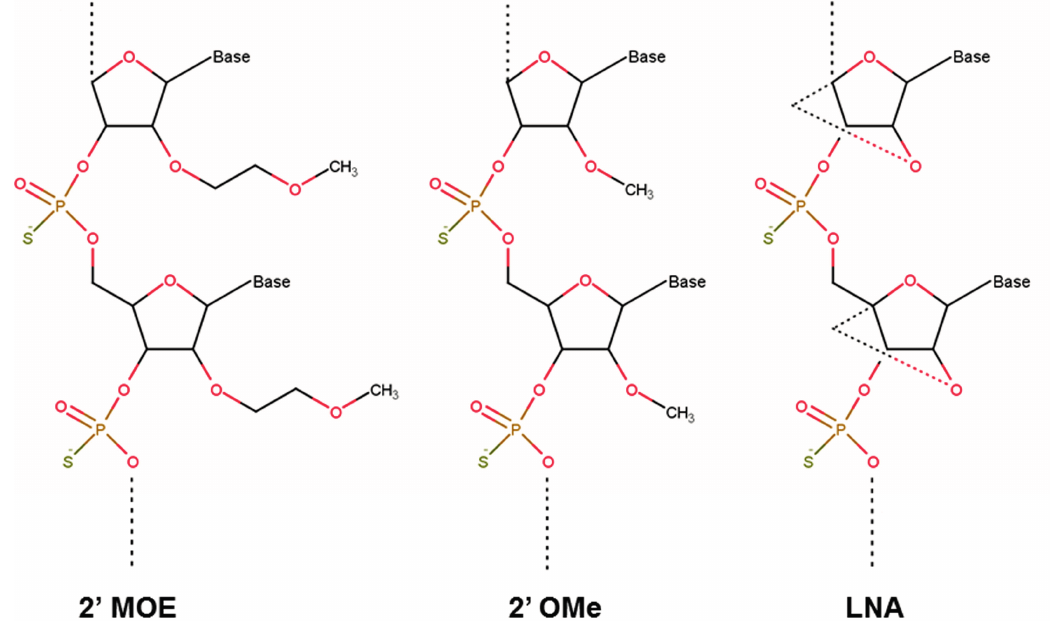
Figure 3. Nucleotide modifications frequently used for gene silencing.